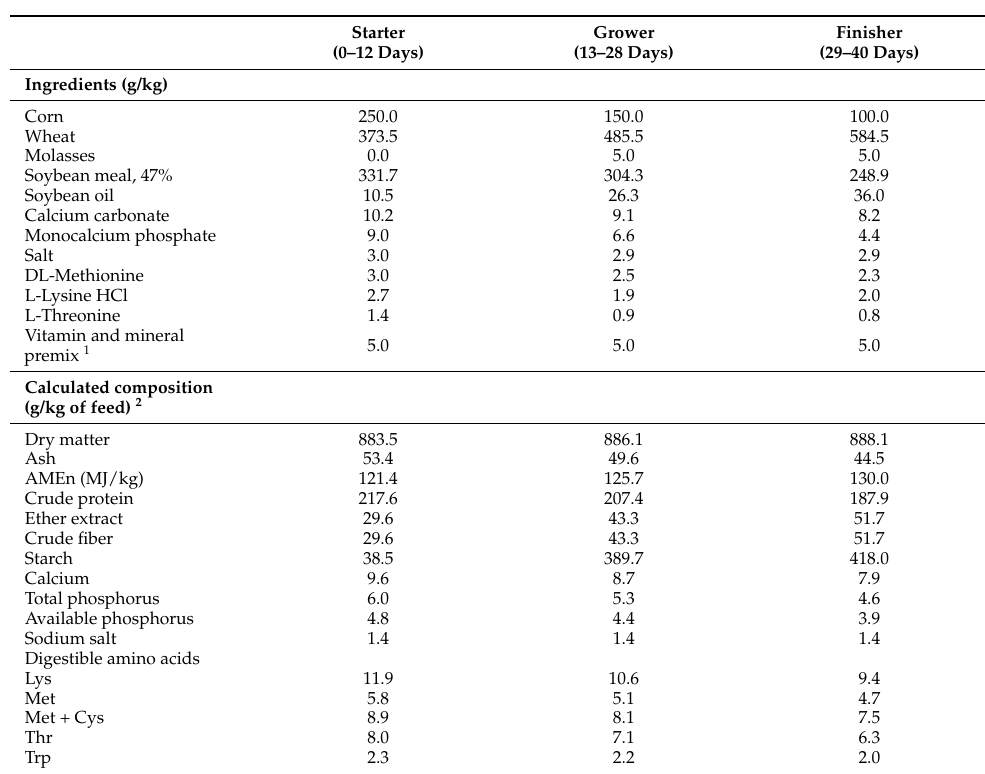
Table A1. Ingredients and calculated composition of the experimental diets (g/kg as fed basis, unless otherwise